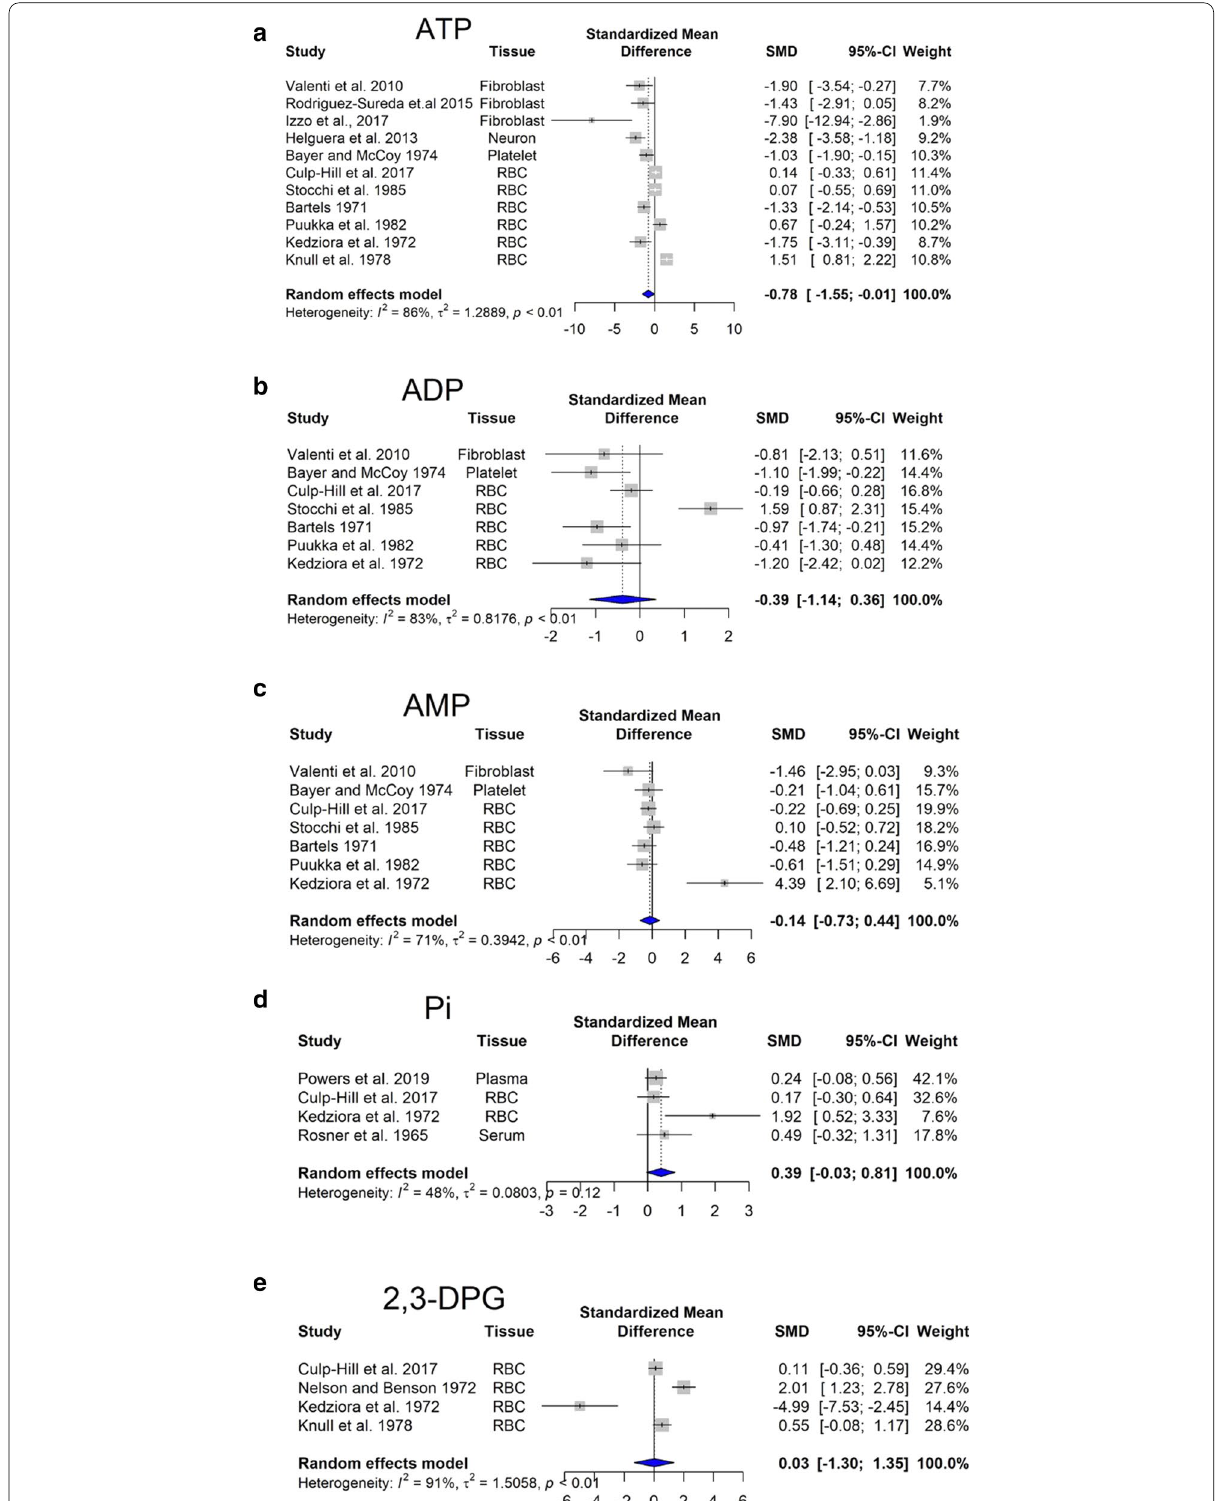
Fig. 1 Changes in bioenergetics-related analytes in Down syndrome. Forest plot showing relative weights, standardized mean difference (Hedge’s g) with confidence intervals. Overall average effect size is displayed by filled